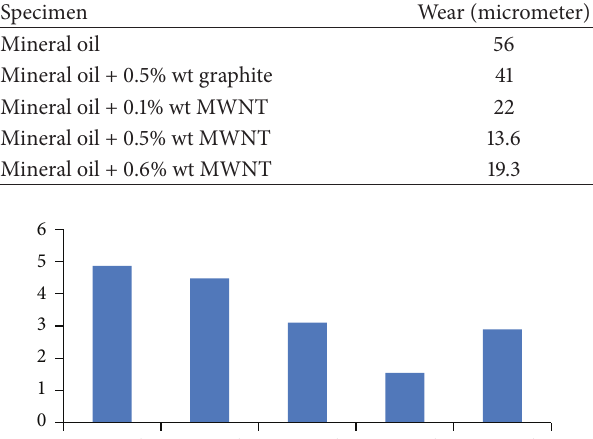
Figure 7: Coefficient of friction for different specimens.